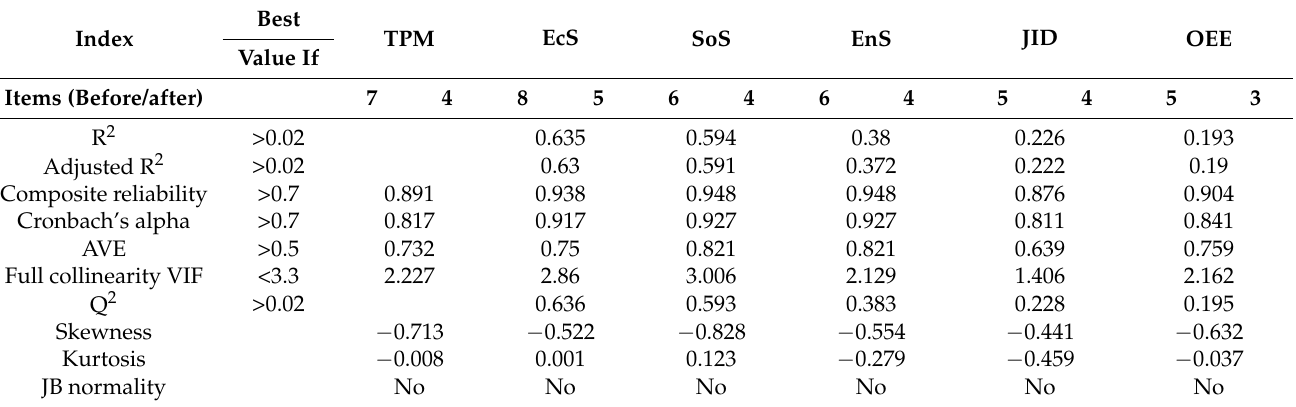
Table 3. Latent variable validation